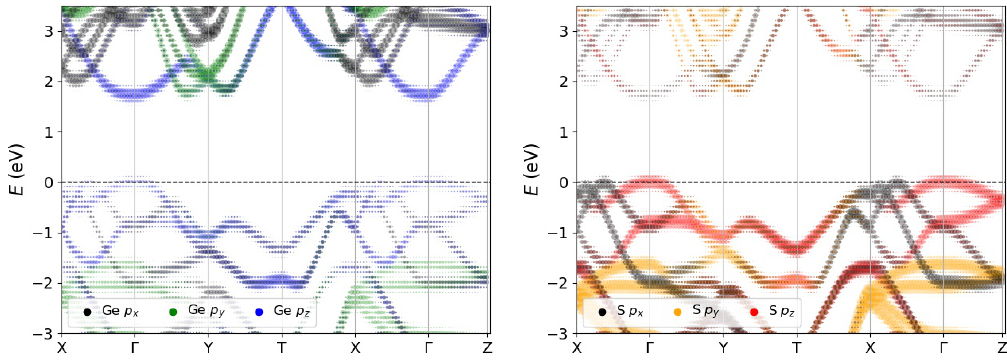
Figure 6. GW bands projected on atomic orbital bands. Left : Ge orbitals; Right : S orbitals.